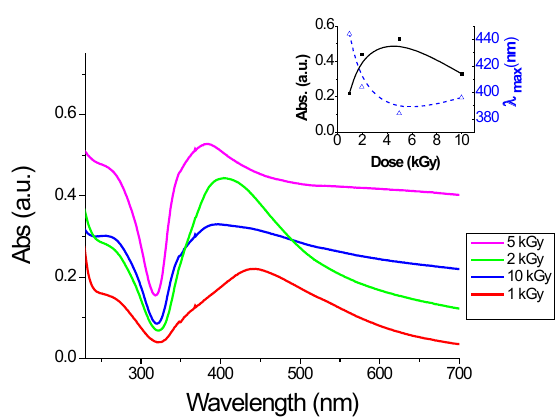
Figure 2. The UV-VIS spectra for the samples obtained by irradiation at low dose rate and IPA composition. Inset: the effect of radiation dose on the absorption peak